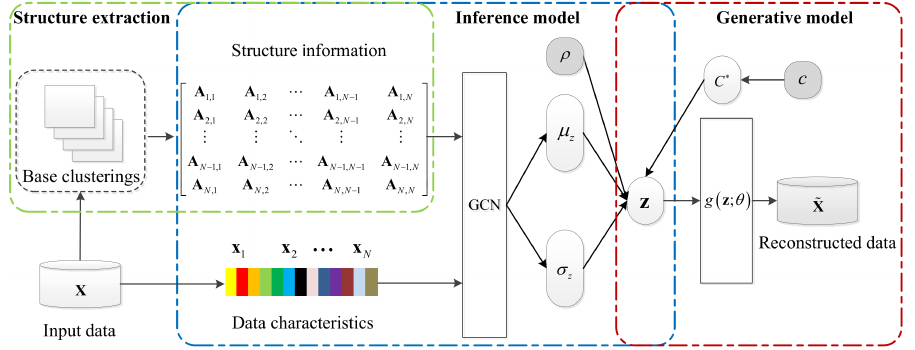
Figure 1. Integral construction of the proposed CEvGE framework. The CEvGE consists of three com- ponents: (i) the structure extraction component is used to explore the global structure of data from a set of base clusterings; (ii) the inference model is realized by a GCN module to encode the data characteristics and information jointly; (iii) the generative model reconstructs input data from latent space and produces the final cluster assignment by a GMM. The whole framework can be optimized jointly by maximizing the ELBO, which is calculated and backpropagated to the latent